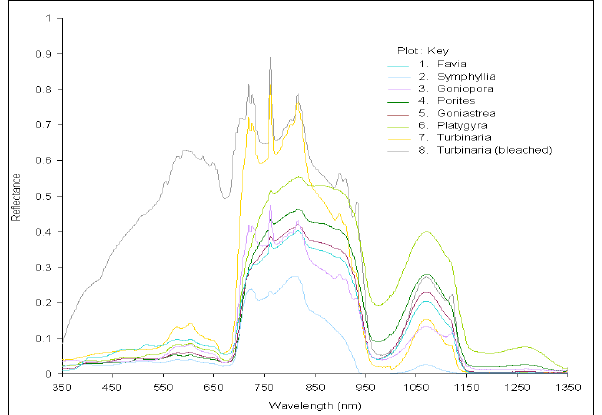
Figure 5. In situ reflectance spectra of the sampled coral targets Group A corals represent the purest form of in situ live